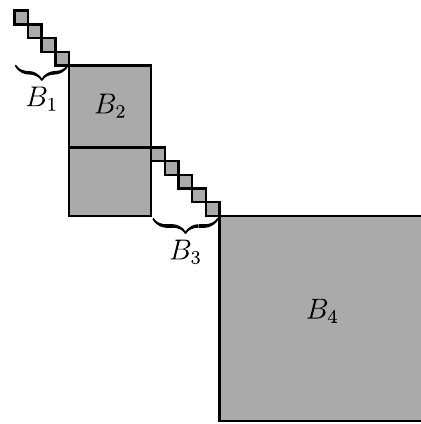
Figure 3 . Block-triangular structure of the matrix in the right-hand side of the di(cid:11)erential system for ~ T . The block B 1 is a diagonal matrix corresponding to L + 1 entries of the form Y ::: 010 ::: . The block B 2 corresponds to 2 L (cid:0) ( L + 1) L= 2 entries T a ( j a j even and j a j 6 = 2). The block B 3 is a diagonal matrix corresponding to ( L + 1)( L (cid:0) 2) = 2 remaining entries of T a with j a j = 2. The block B 4 corresponds to 2 L entries T a with odd j a j